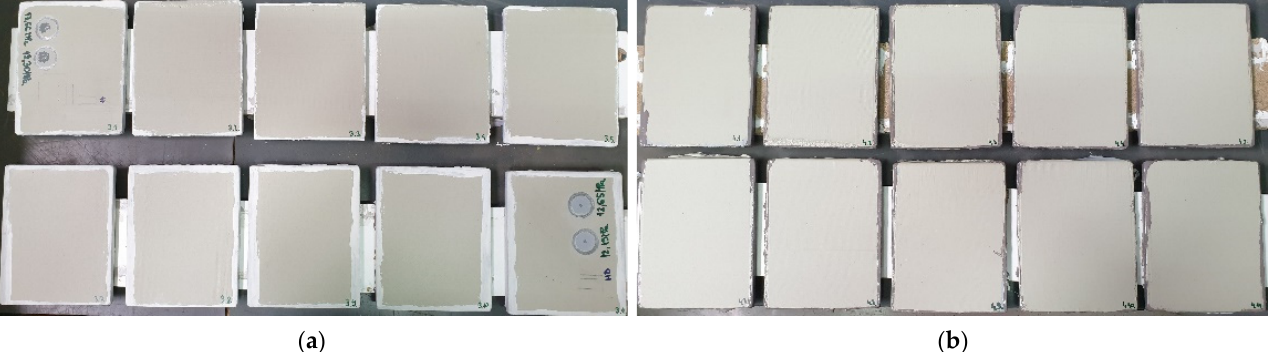
Figure 1. Applied coating system on mild steel plate S235JR + N with ( a ) and without ( b ) zinc in the primer according to Table 2.